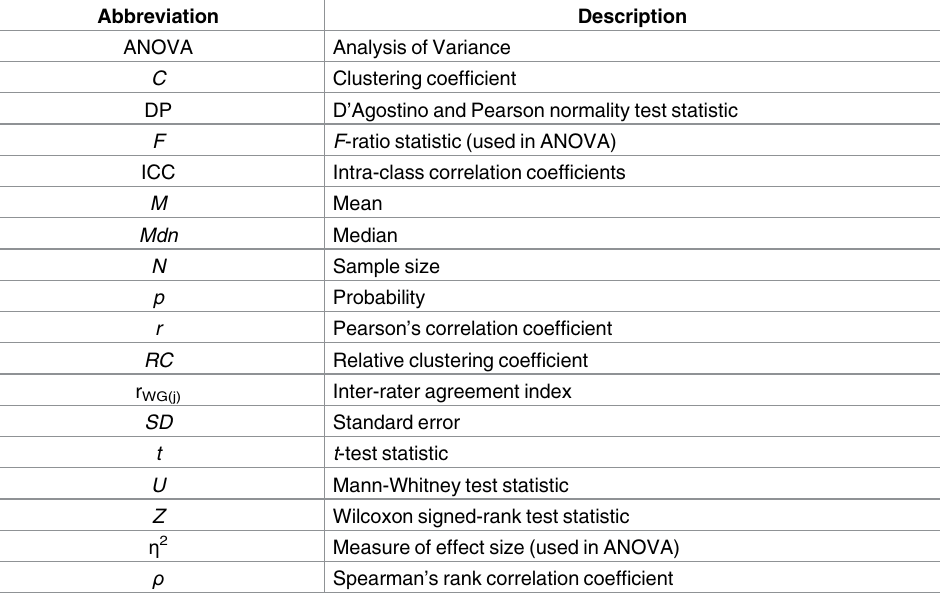
Table 1. Table of abbreviations used in the